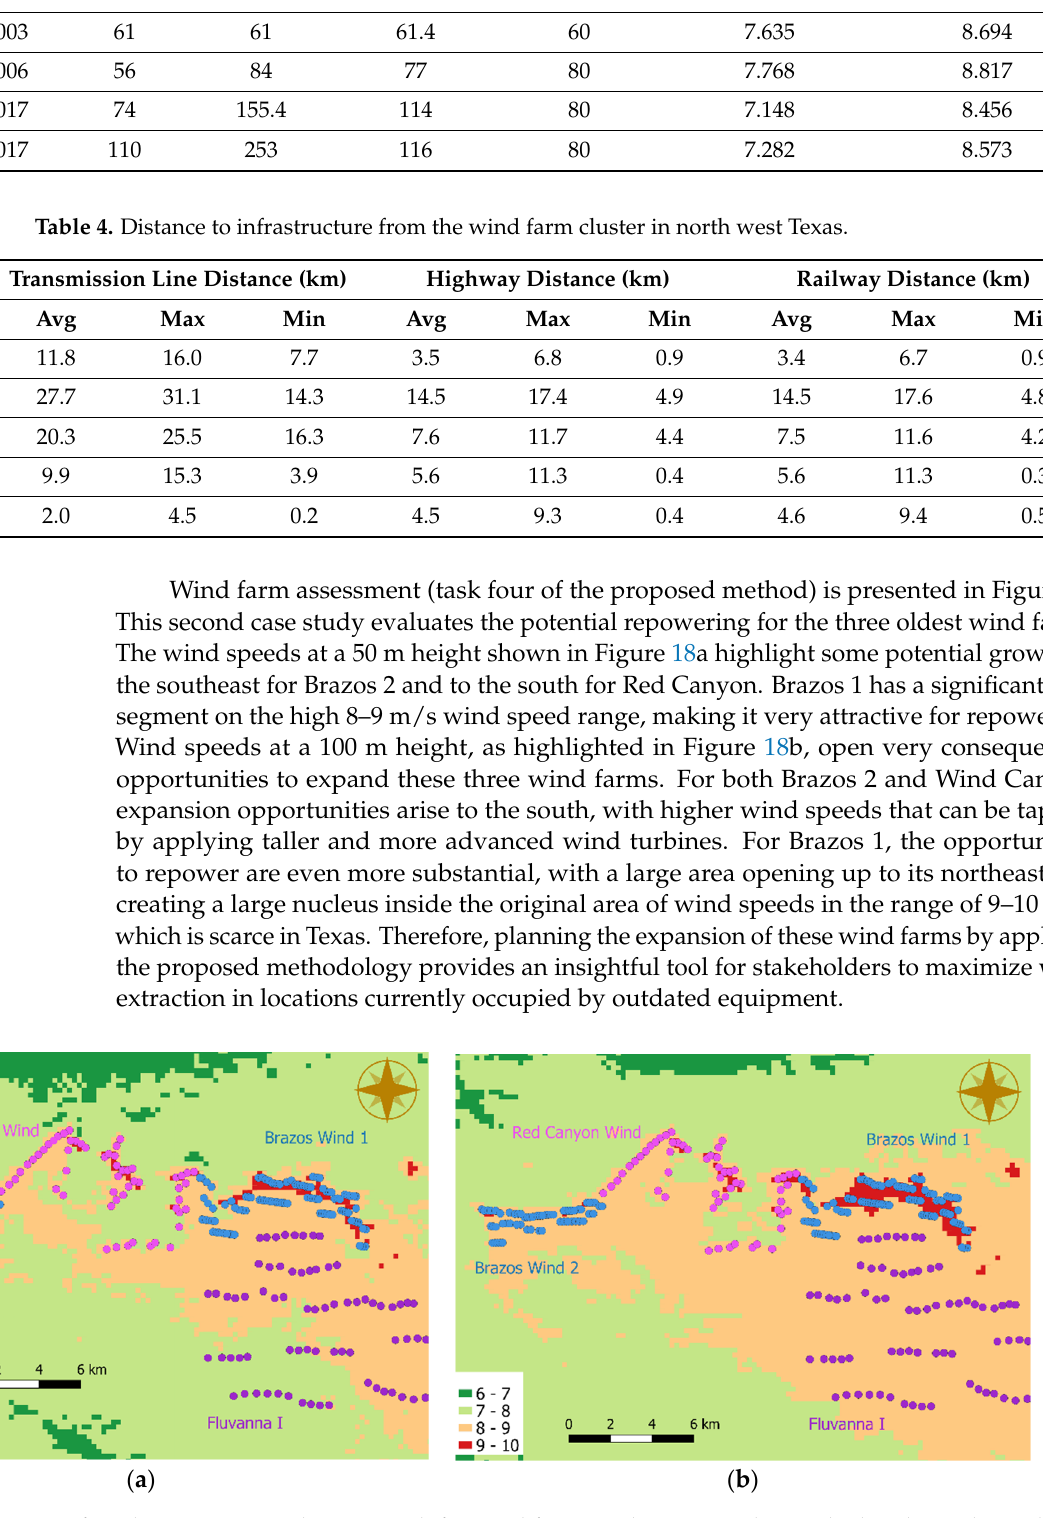
Figure 18. Evaluation of total repowering and size growth for wind farms in this case study, overlaid with wind speed vector at ( a ) 50 m height and ( b ) 100 m height.